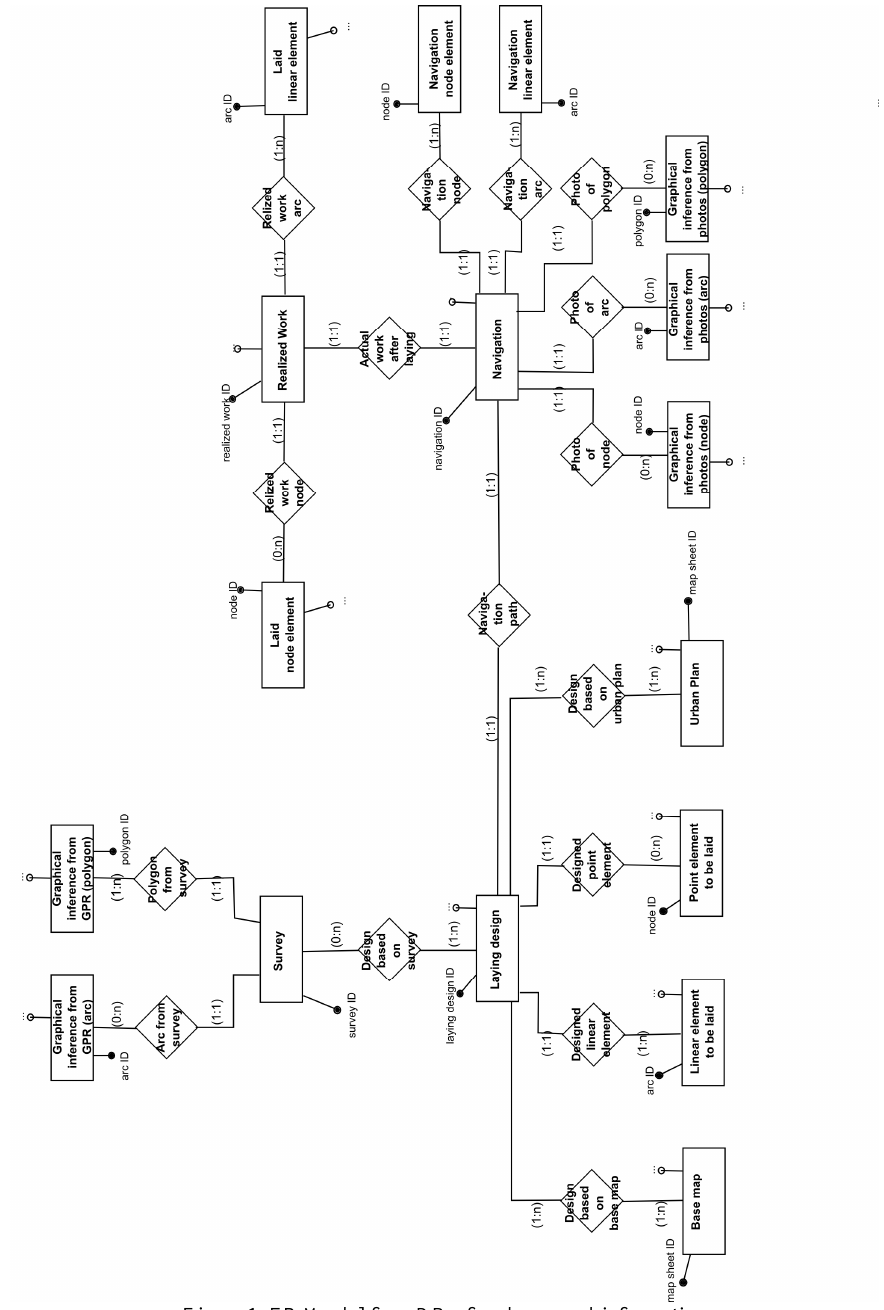
Figure 1. ER Model for a DB of underground